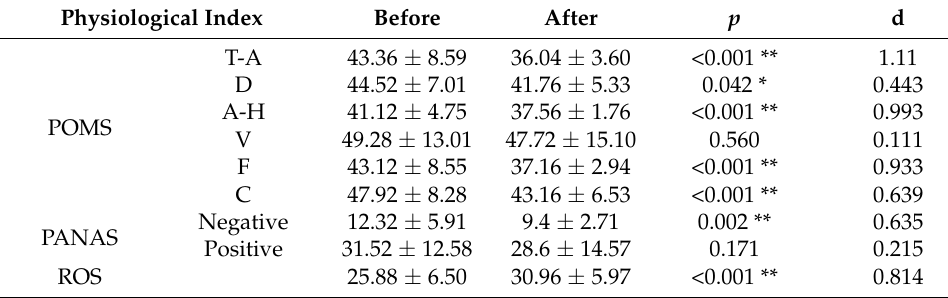
Table 5. Comparison of before and after digital forest bathing experience. Physiological Index